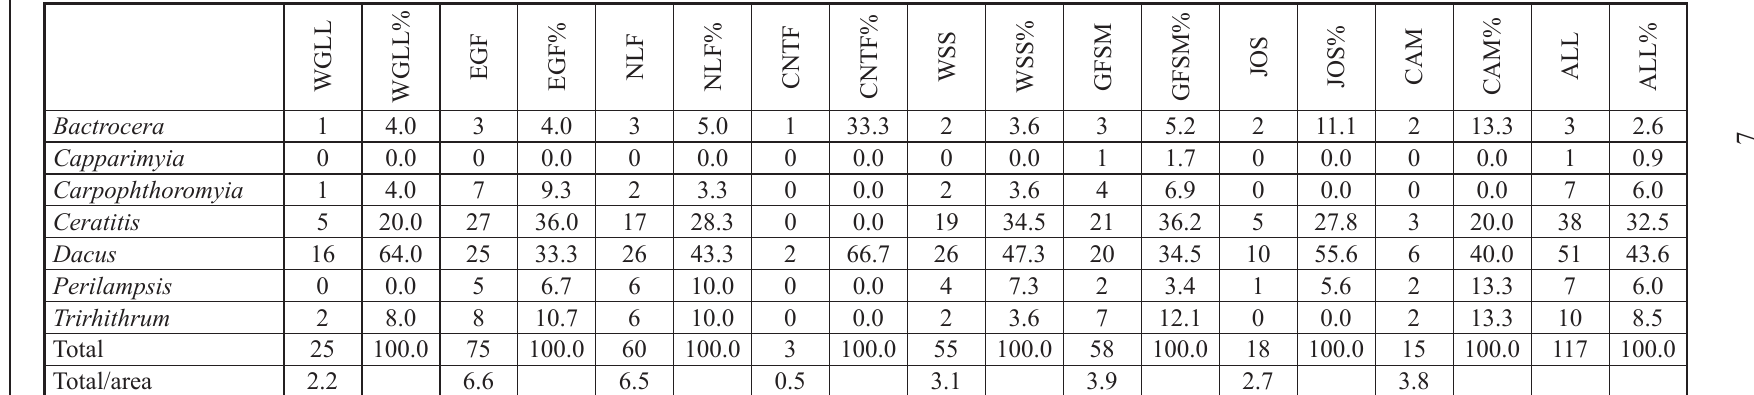
Table 2. Species richness by genus for Tephritidae in the ecoregions within the study area (abbreviations: WGLL = West Guinean Lowland